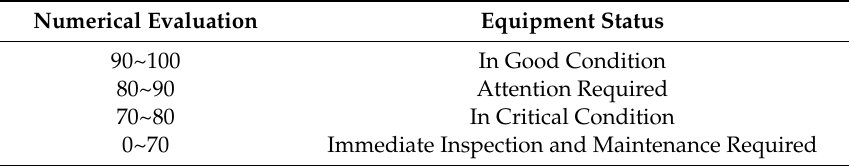
Table 3. Equipment status ratings and the corresponding numerical evaluation ranges.